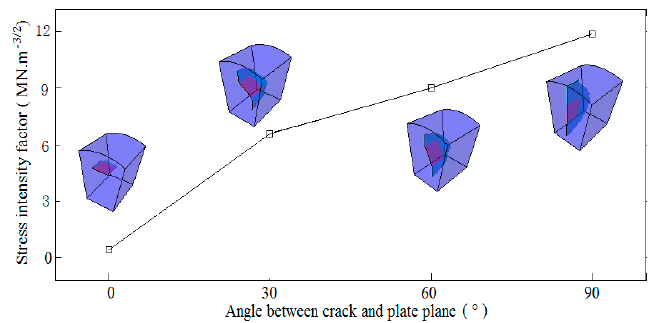
Figure 8. Susceptibility of the inclined angle to solidification cracking.